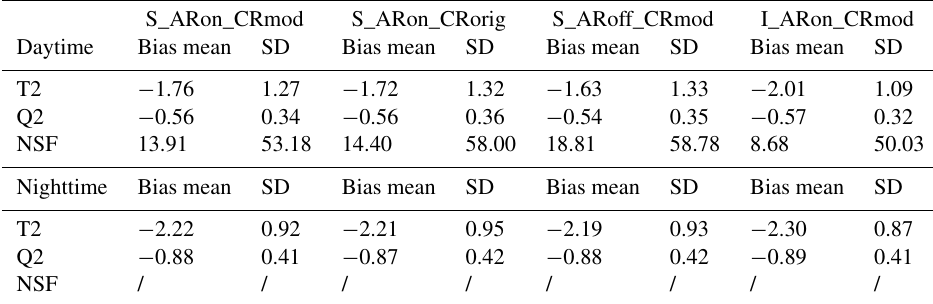
Table 4. Hourly bias mean and standard deviation (SD) in daytime and nighttime of 2m temperature (T2, ◦ C), water vapor mixing ratio (Q2, T2 and Q2 are calculated using 24 surface stations and NSF is calculated using 42 CIMIS stations shown in Fig. 4.